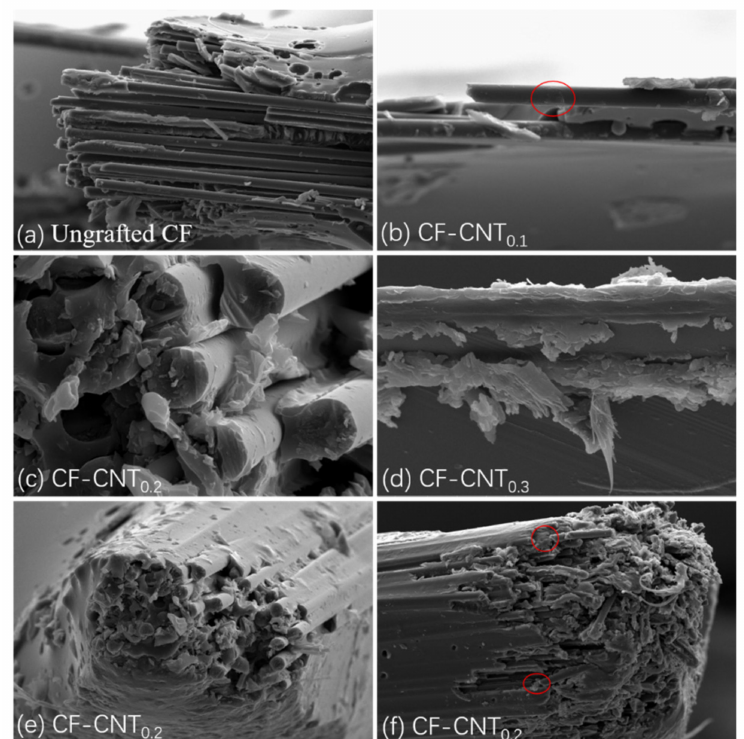
Figure 7. Microscopic morphology of laminate failure: ( a ) ungrafted CNT samples; ( b ) samples grafted with 0.1 mg / mL CNT concentration; ( c , e , f ) samples grafted with 0.2 mg / mL CNT concentration; ( d ) Samples grafted with 0.3 mg / mL CNT